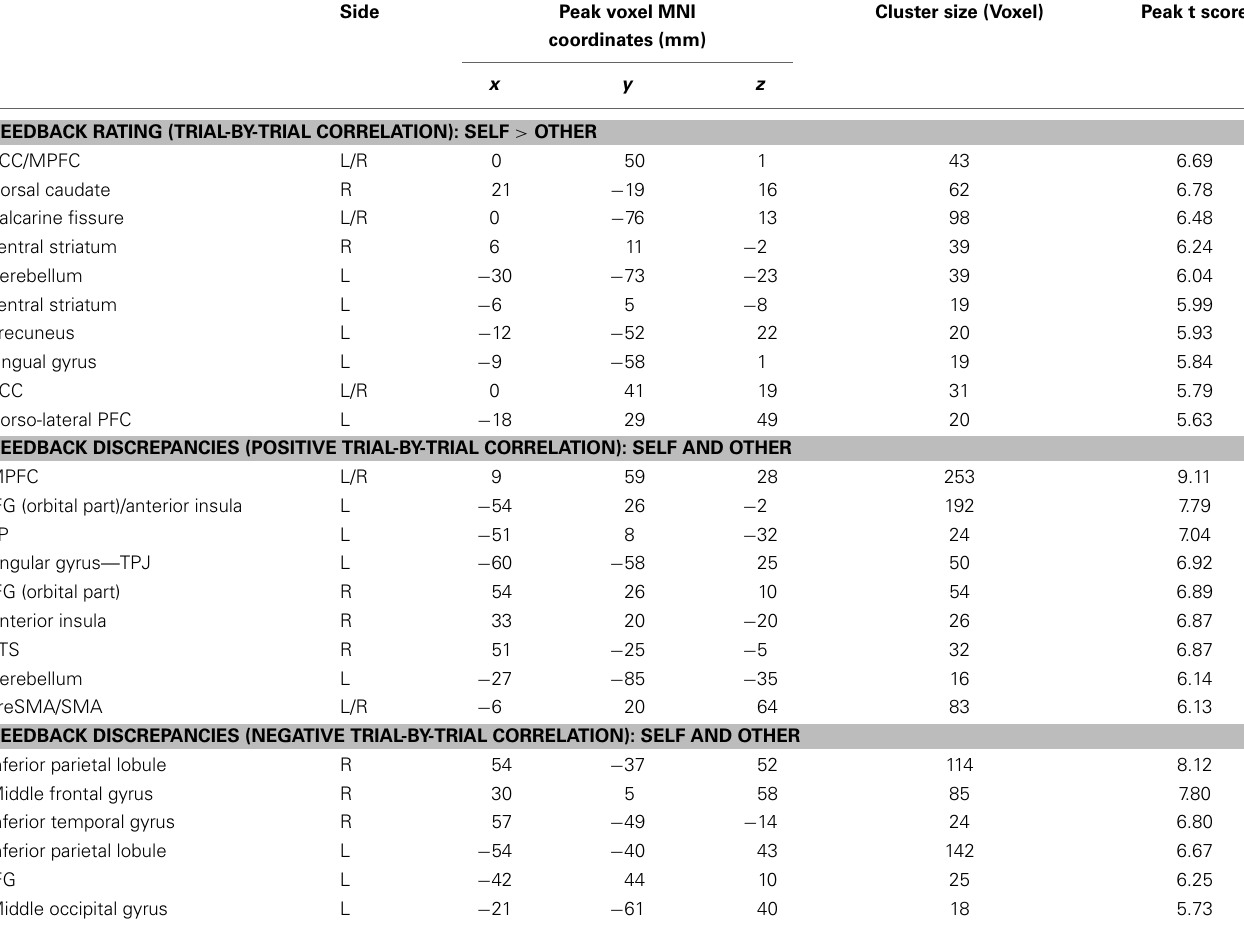
Table 4 | Changes in BOLD signal related to reward- and comparison-related components of social feedback. Side Peak voxel MNI Cluster size (Voxel) Peak t score coordinates (mm) x y